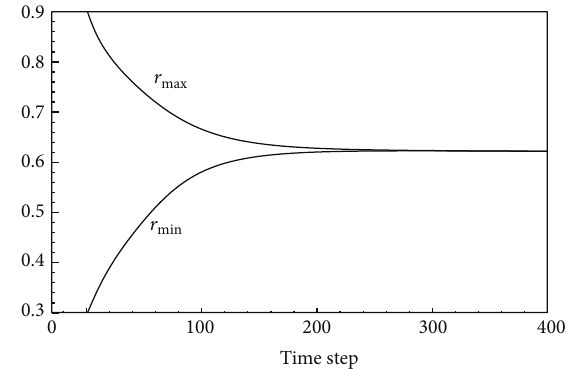
Figure 5: Plot of 𝑟 max (upper curve) and 𝑟 min (lower curve) showing thedistancefromtheorigintotheinterfaceasafunctionoftime 𝑡 on a 64 × 64 grid with 𝑁 𝑏 = 160 on the boundary. The maximum and minimum radii will converge to the radius of a near-circle shape.